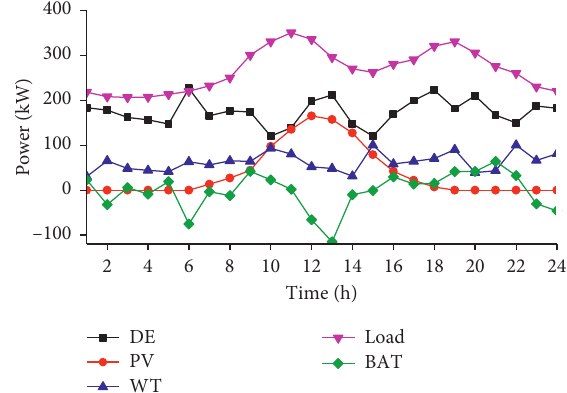
Figure 10: Output power of generation units at the minimum battery depreciation cost.